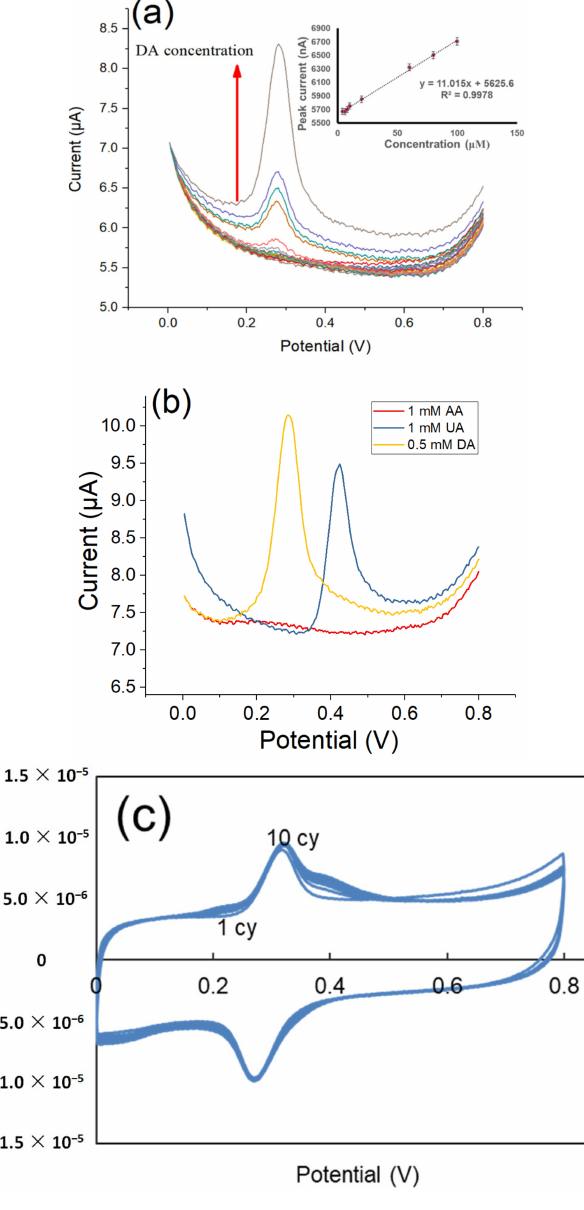
Figure 9. Di ff erential pulse voltammetry (DPV) curves of ( a ) MOF525 / PEpC modified microelectrode in ABS (pH = 5) with DA concentrations from 4 to 100 µ M (Inset: linear dependence of the peak current against DA concentration), ( b ) detection of AA, UA and DA, respectively, and ( c ) stability of MOF525 / PEpC modified microelectrodes in 10